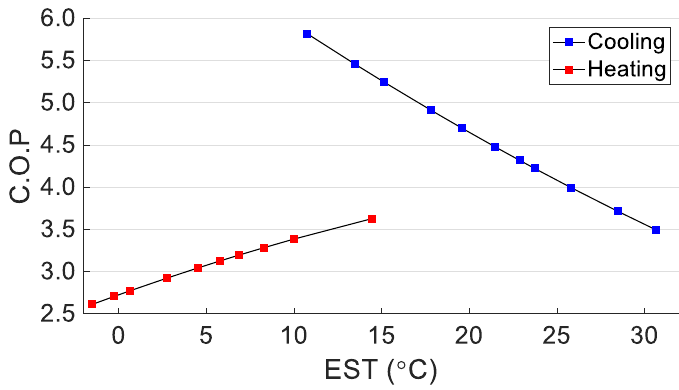
Figure 5. Annual building load profile (cooling (+) and heating (−)).